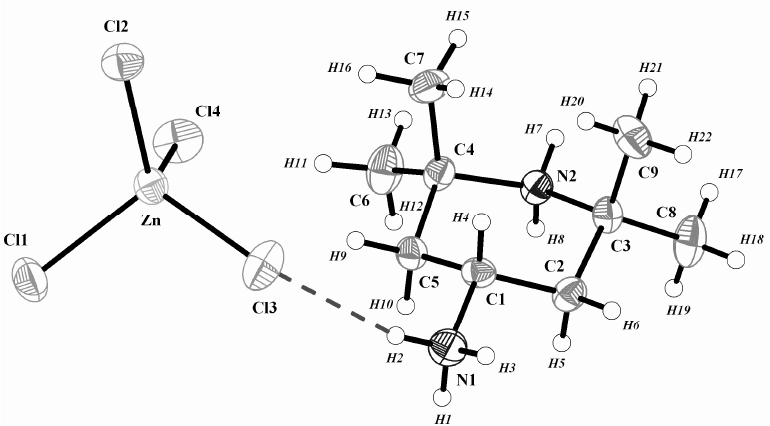
Figure 1. Asymmetric unit of [C displacement ellipsoids for non- H